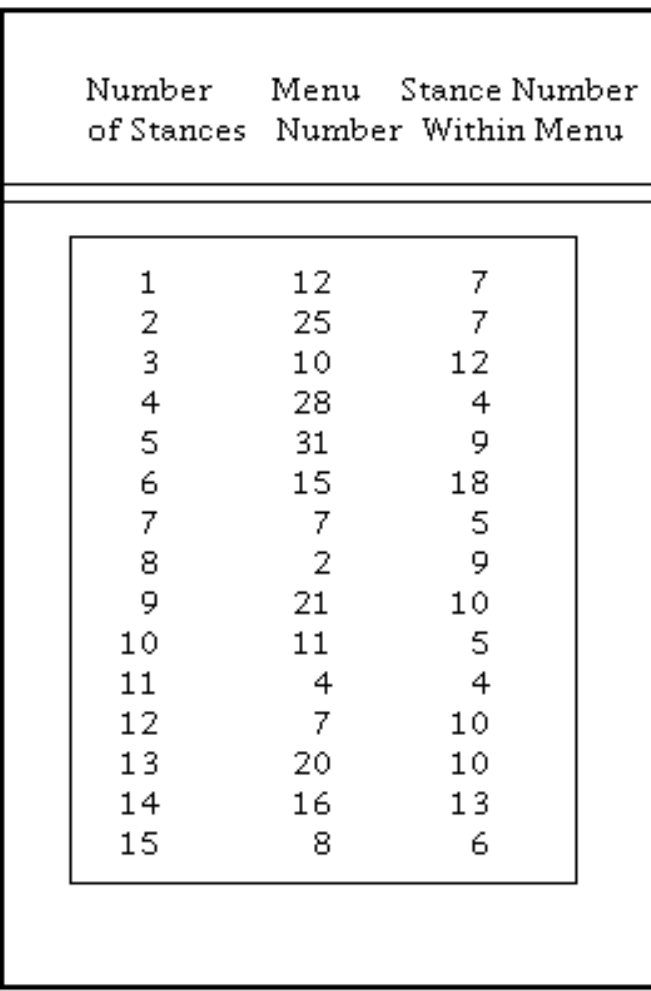
Figure 4.8. “CKExitStances” Chance